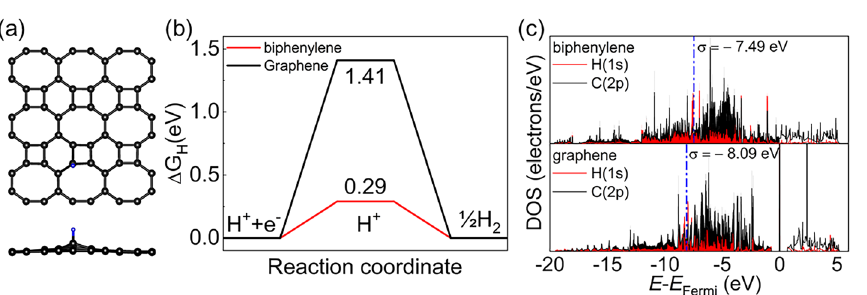
Figure 4. ( a ) Top and side views of the most stable adsorption configuration; ( b ) Gibbs free energy for HER; ( c ) projected density of states for H atom adsorption on biphenylene and pristine